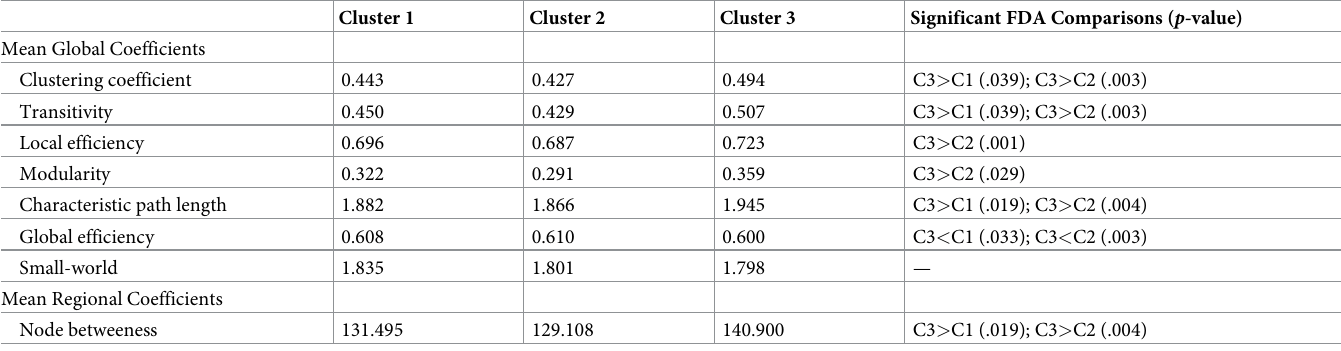
Table 2. Cortical thickness network comparisons of topological measures.